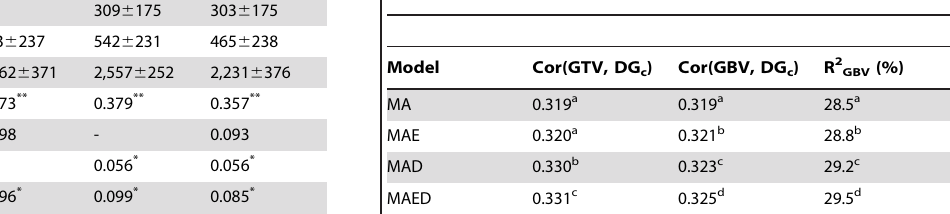
), epistatic Table 2. Estimates of additive genetic variance ( s 2 a ), dominance variance ( s 2 ), litter variance ( s 2 ), variance ( s 2 aa d l ) and their standard errors, and the residual variance ( s 2 e proportions of these variances ( h 2 ,h 2 ,h 2 ,l 2 ) to phenotypic a aa d variance (defined as the sum of variance components in the model). Table 4. Correlation between corrected daily gain (DG c ) and predicted total genetic value (GTV, defined as the sum of genetic effects in the model), between DG c and estimated additive genetic effect (GBV), and reliability of GBV (R 2 GBV ), for the animals in the test